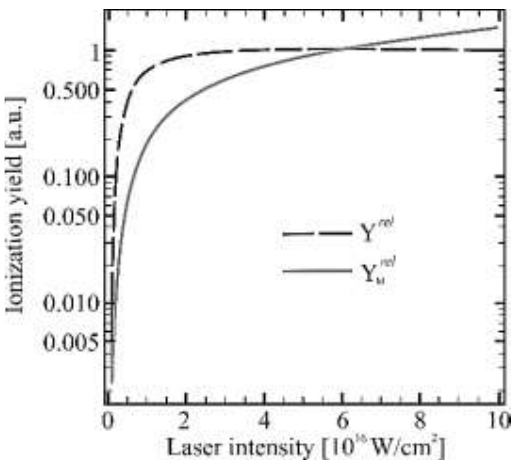
Figure 4. A comparative review of the ammonia ionization yields without, 𝑌 𝑟𝑒𝑙 (𝐹, 𝑅) (dashed line), 𝑟𝑒𝑙 (𝐹, 𝑅, 𝑡) (solid line). Field intensity varies within the and with correction of the magnetic field, 𝑌 𝑀 range 10 16 < 𝐼 < 10 17 Wcm −2